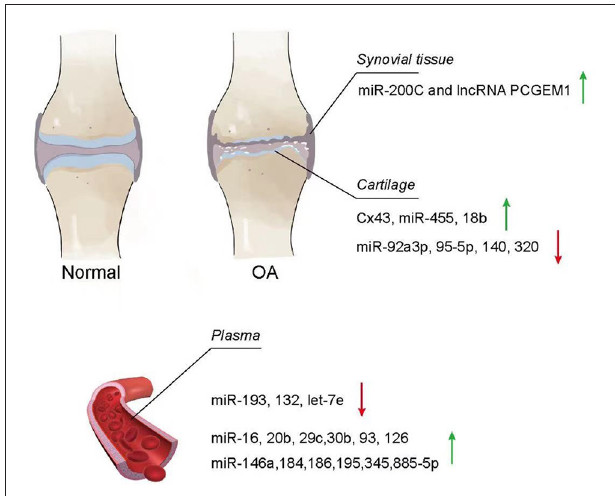
FIGURE 3 | Change of EVs from osteoarthritis ( OA). Exosomes in the synovial tissue, cartilage, and plasma of patients with OA showed different increasing and decreasing trends compared with normal